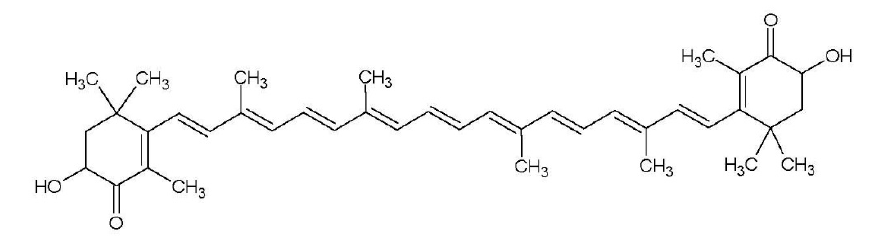
Figure 1. Chemical structure of bioactive compound astaxanthin.